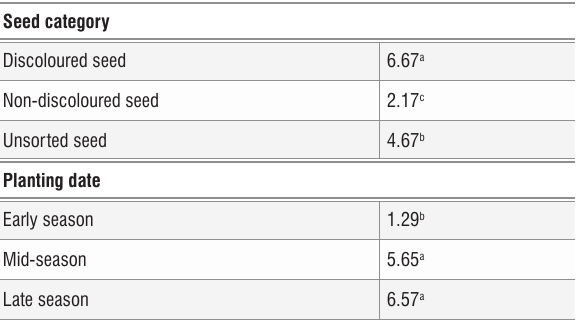
Means for seed category and planting date effects on Phaeoi­ sariopsis spp .